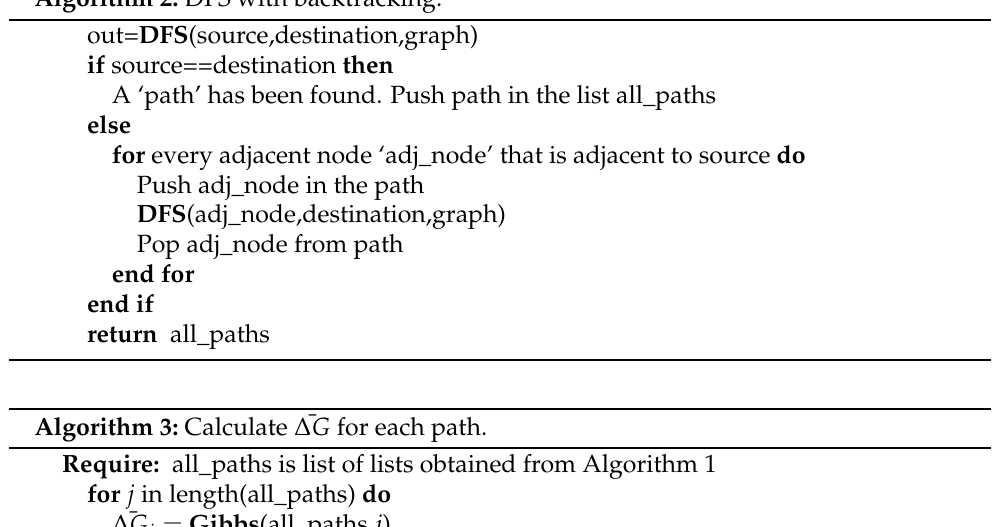
Algorithm 2: DFS with backtracking.